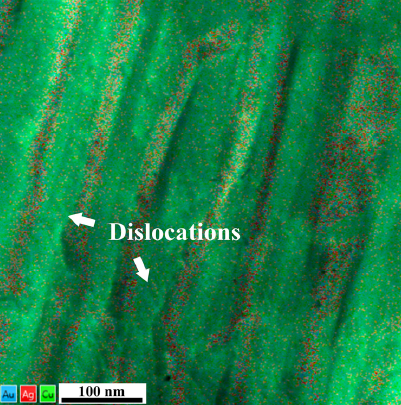
Figure 4. The TEM observation of dislocations in the GB lamellar regions near the